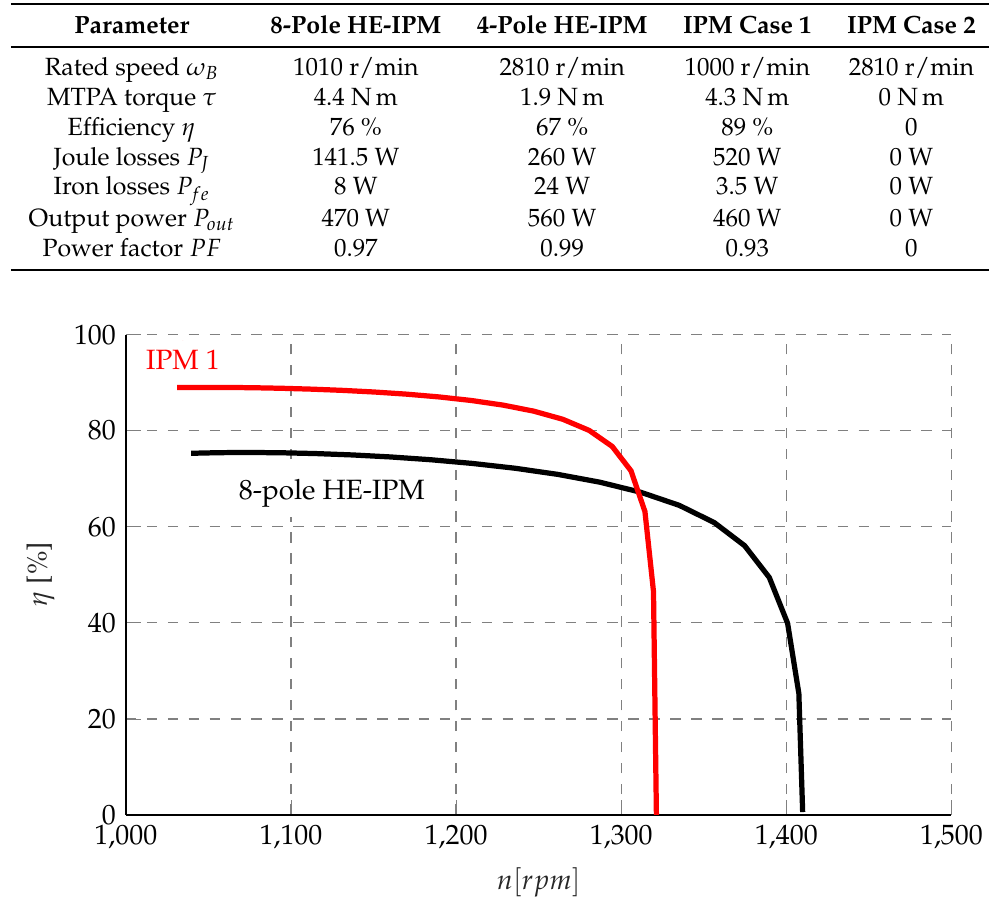
Figure 25. Flux weakening operation with different excitation currents.